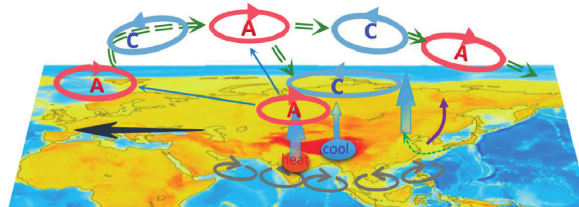
Figure 13: Schematic diagram showing the mechanism of tripole pattern. The letters denote anticyclonic and cyclonic circulation centers in 200 hPa. Black arrow denotes the easterly jet. Grey arrow denotes Kelvin waves. Purple arrow denotes PJ pattern. The green dashed arrow denotes water vapor